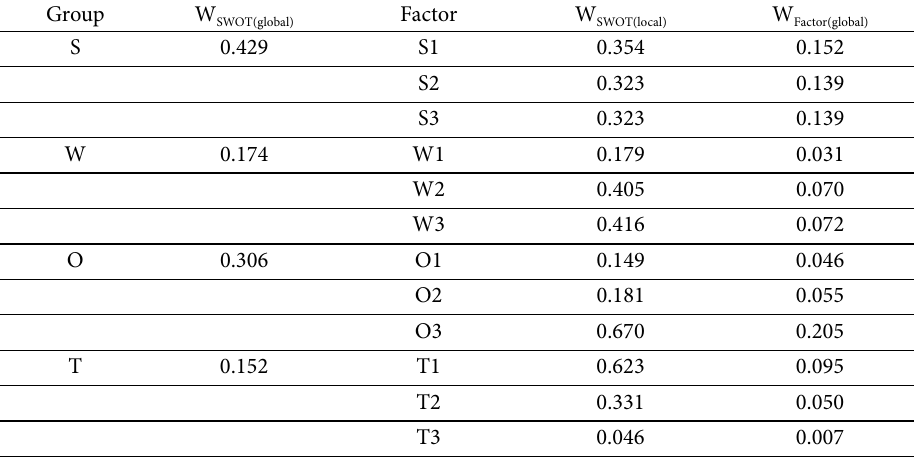
Table 12. The computed results for all